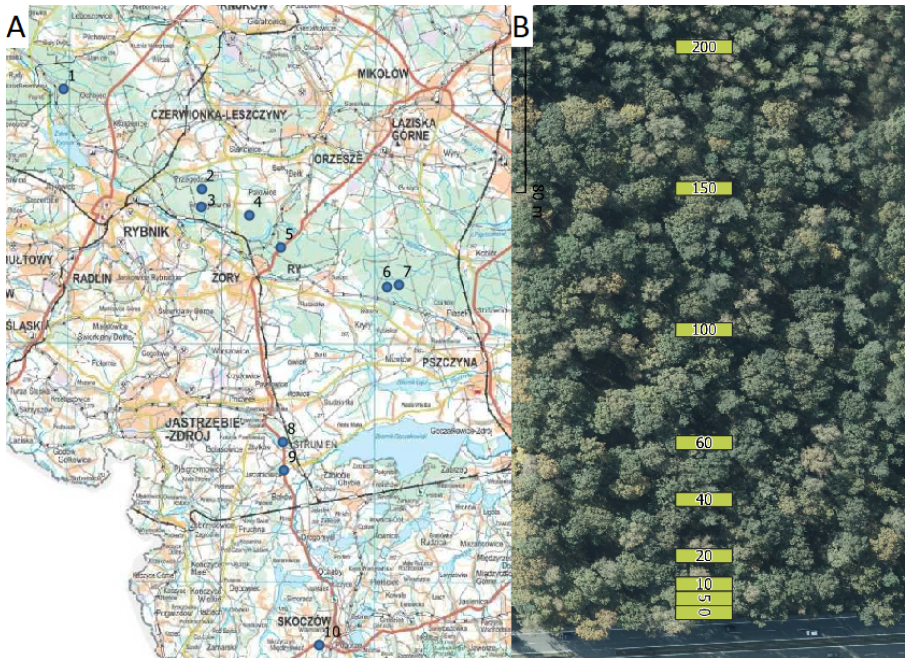
Figure 1. The location of ten transects in the study area in southern Poland ( A ) and the location of nine plots within a transect ( B ).